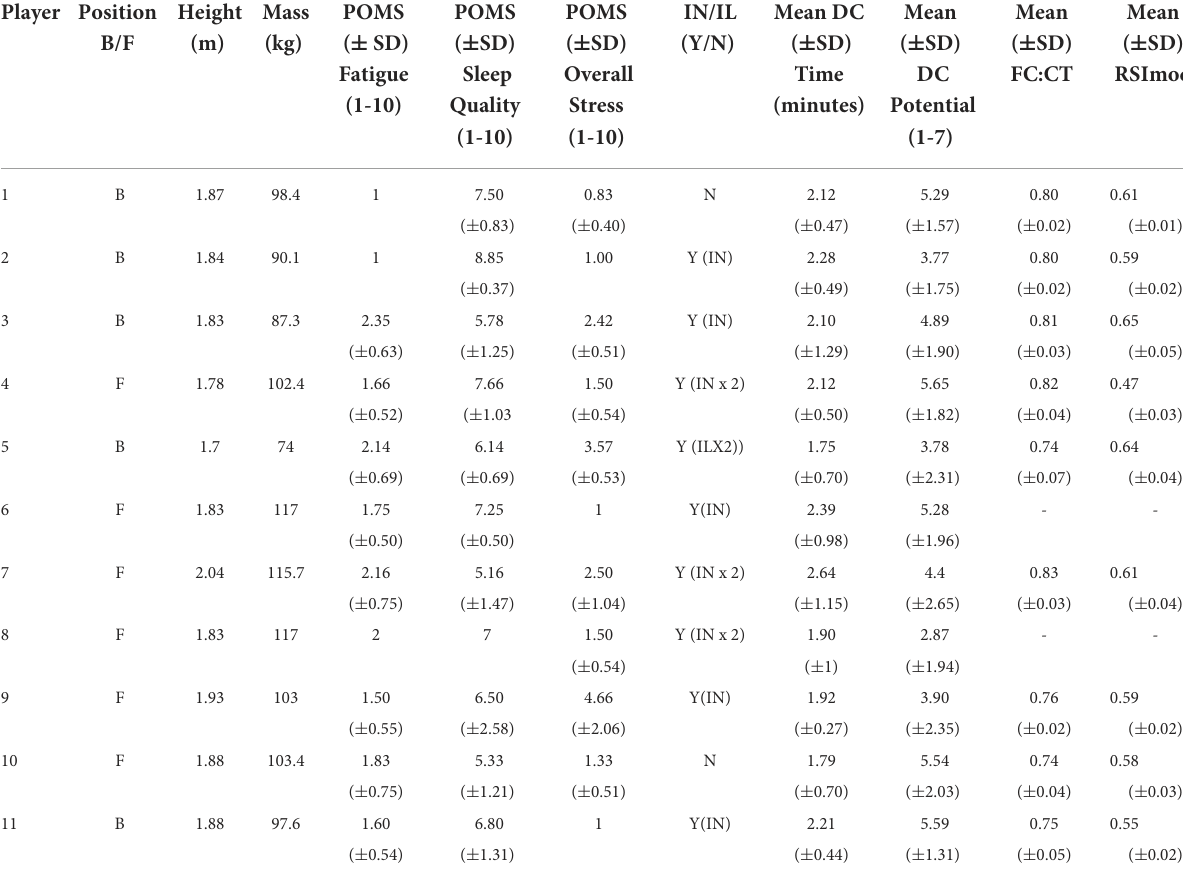
TABLE 1 All players (n = 11) summarised self-reported (POMS), DC potentials and reactive strength index modified (RSImod) data. Player